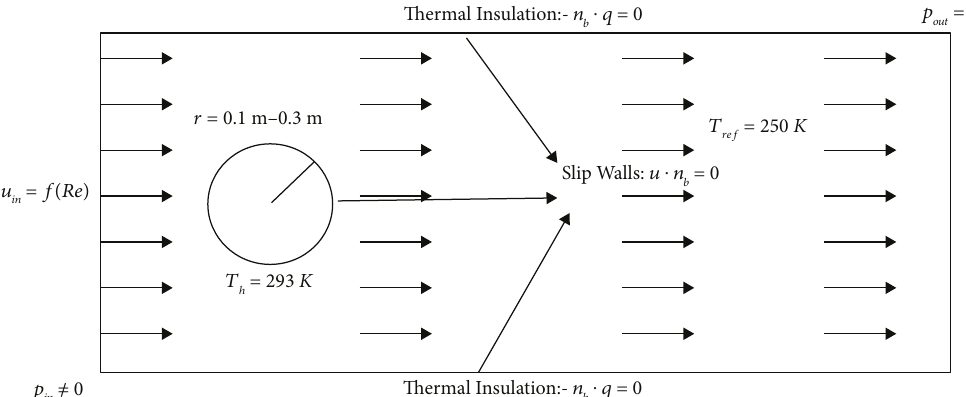
Figure 1: Schematic diagram of the channel with a description of the boundary conditions for the laminar flow and heat